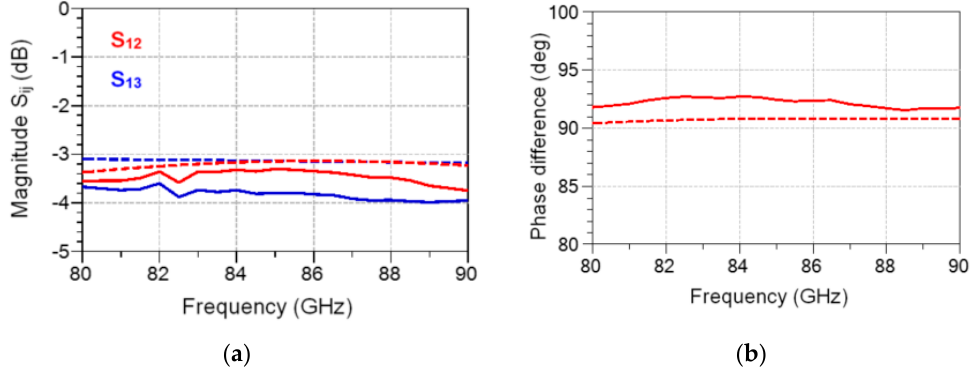
Figure 29. MHMIC 90° hybrid coupler prepared for measurements.